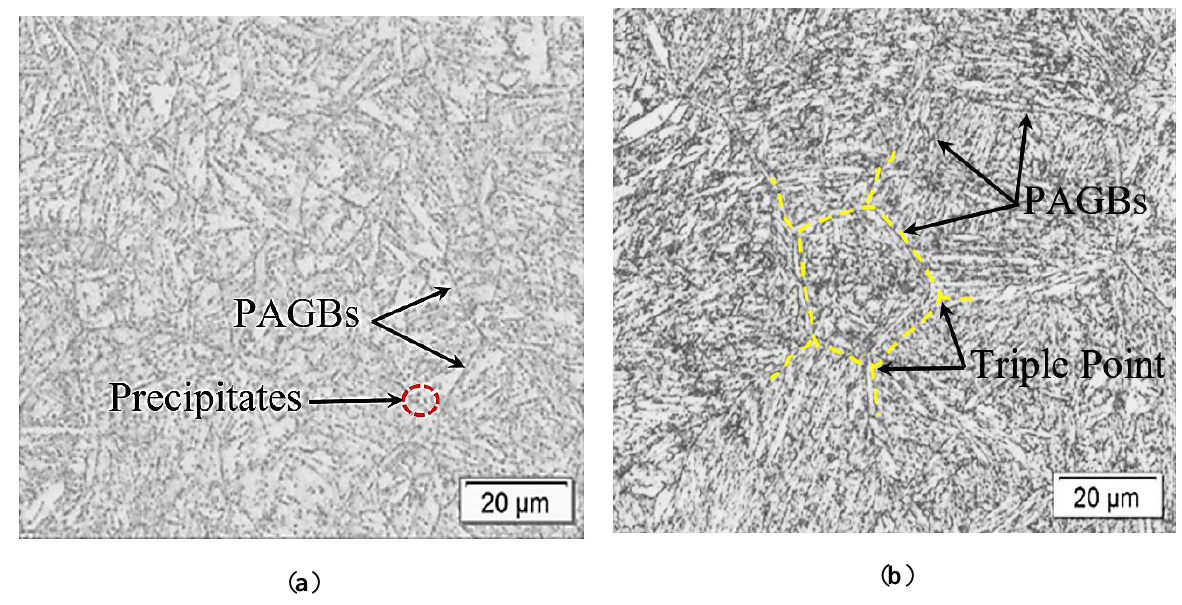
Figure 2. The optical micrographs for ( a ) steel A and ( b ) steel B.